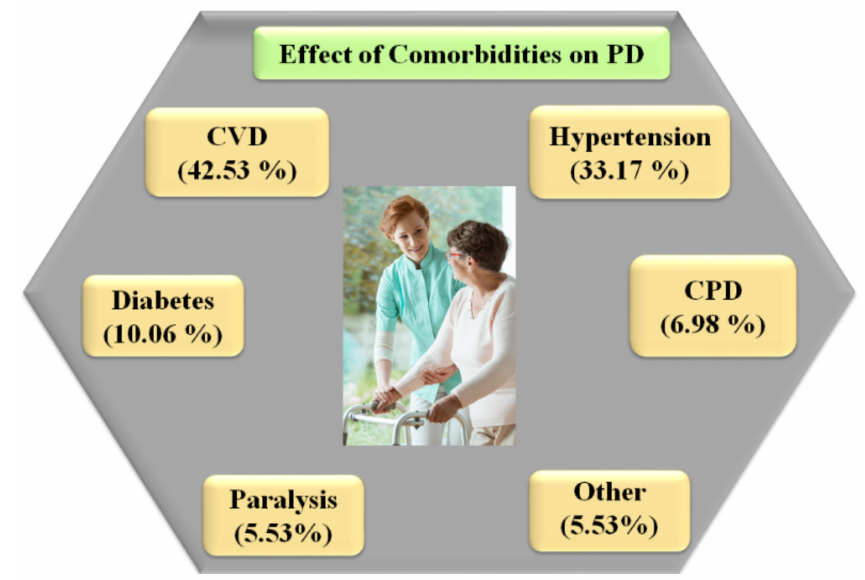
Figure 10. Effect of comorbidities on PD with or without COVID-19 [162]. Table 3. Studies showing the effect of COVID-19 on